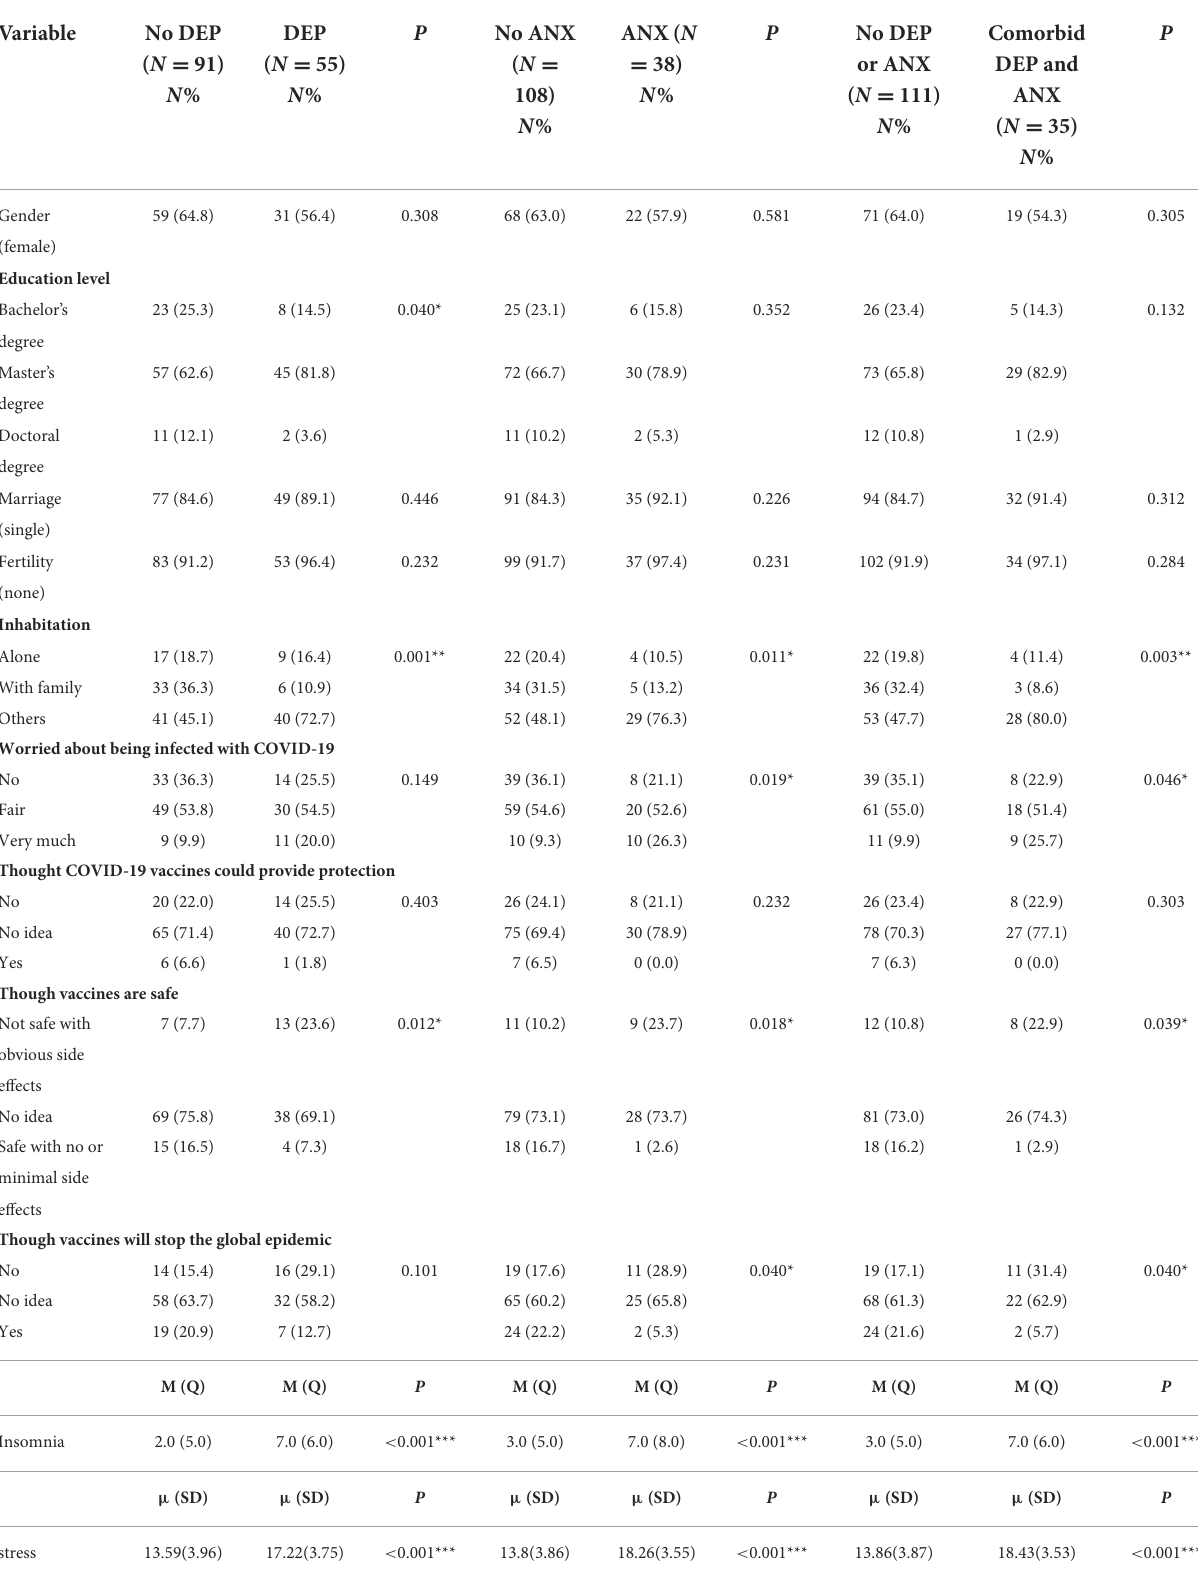
TABLE 1 The sociodemographic and clinical characteristics of the study participants.